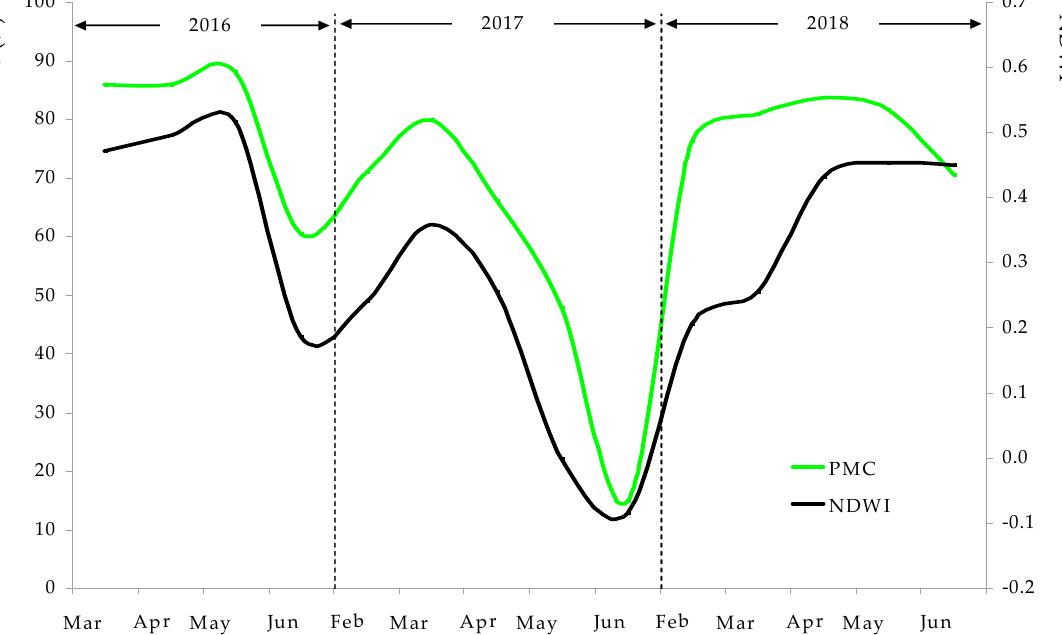
Figure 10. Monthly evolution of pasture moisture content (PMC) and normalized difference water index (NDWI) in three consecutive springs (2016–2018). Data are average values of the 12 sampling points. Figure 11 shows the relationship between NDWI and PMC and between NDWI and PQDI. Pasture moisture content is a parameter indicative of plant vegetative vigour, with a tendency to decease at the end of the growth cycle. In the case of “relatively dry year” (2017), PMC in June was extremely